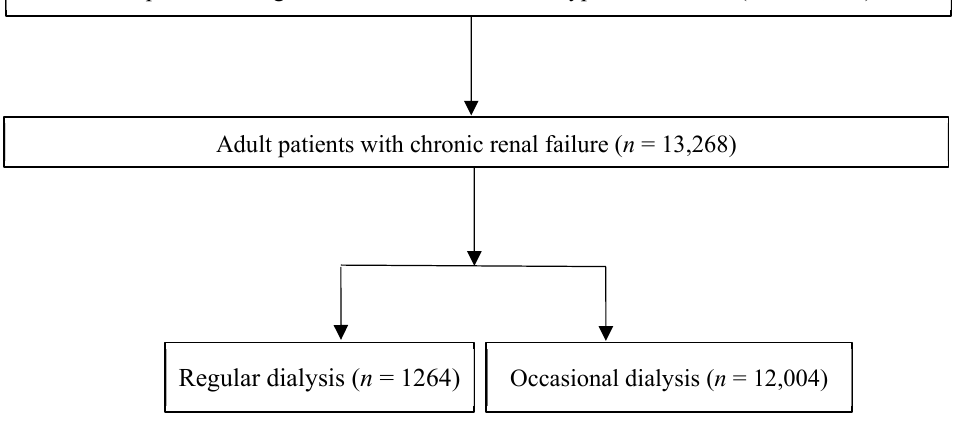
Figure 1. Flow diagram of patient enrollment.